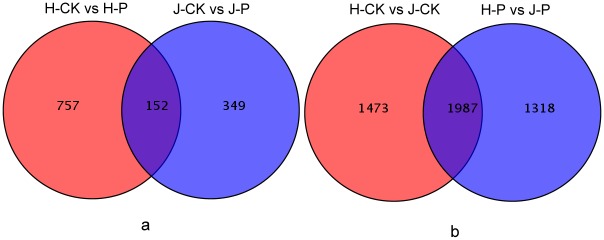
Number inside the parentheses indicates the number of DEGs [P<0.001 and fold change >2.0].(a) Differentially expressed genes (DEGs) between ‘Hongfen’ pear (H-CK/H-P) inoculated with distilled water and PBS and ‘Jinjing’ pear (J-CK/J-P) inoculated with distilled water and PBS. (b) DEGs derived from different varieties receiving the same treatment; 1987 DEGs were detected in ‘Hongfen’ pear and ‘Jinjing’ pear from both the water treatment (H-CK/J-CK) and PBS inoculation (H-P/J-P).